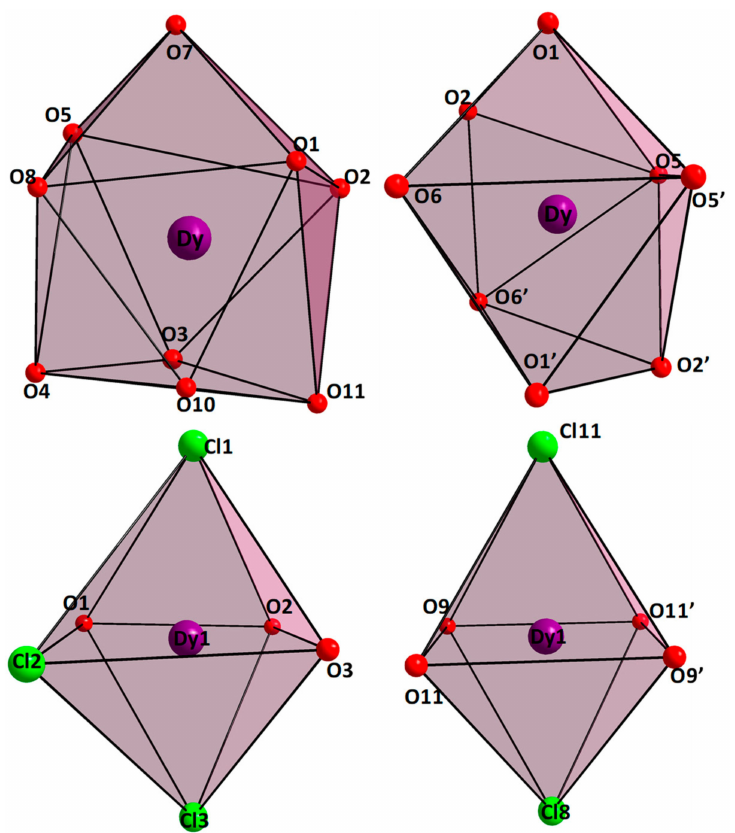
Figure 2. Coordination environments in ( top left ) 1 ; ( top right ) 2 ; ( bottom left ) 3 and ( bottom right ) 4 and 5 . Points connected by the black lines define the vertices of the polyhedron. Colour scheme: Dy III , purple; Cl, green; O,